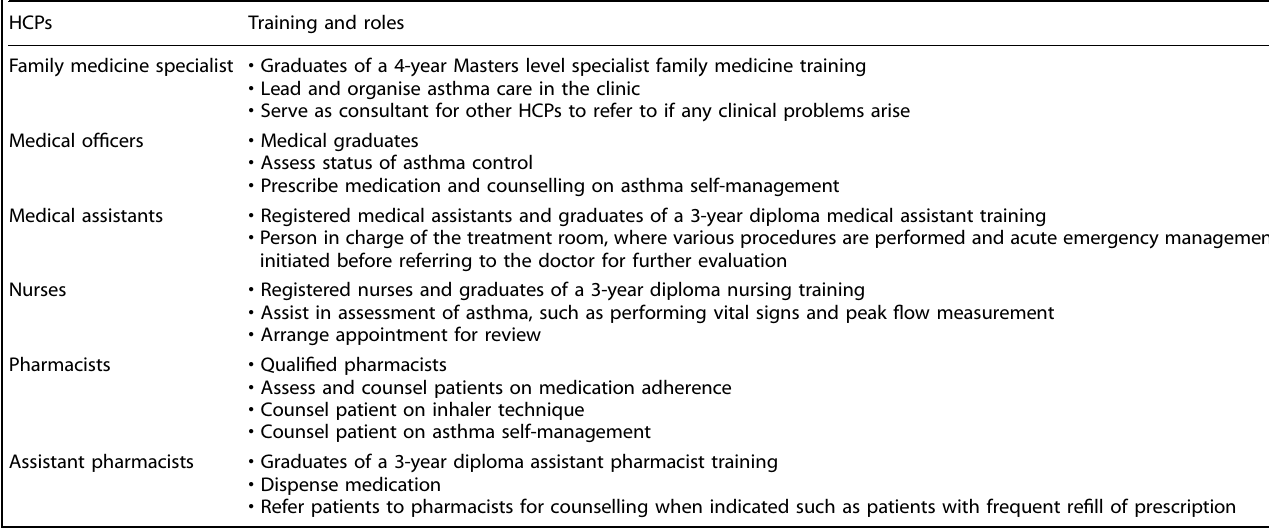
Table 1. Roles of HCPs in asthma management in public primary care clinics. HCPs Training and